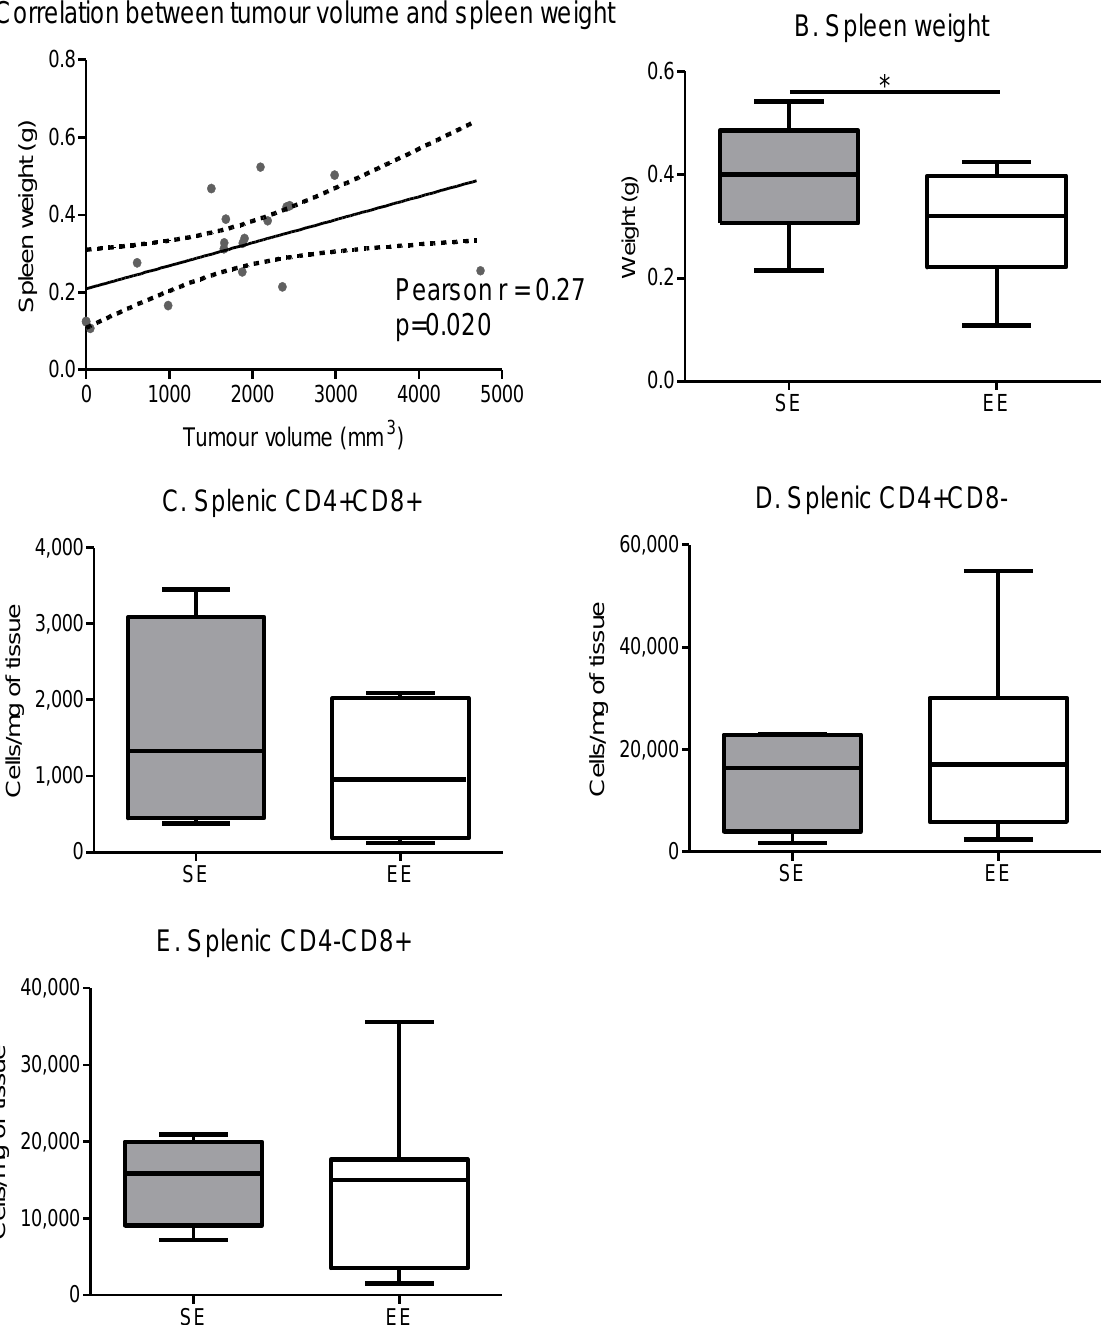
Figure 8. Spontaneous physical activity decreases spleen weight in correlation with tumour volume. ( A ) Correlation between tumour volume and spleen weight independent of environment, data were analysed by Pearson’s correlation test ( n = 10 mice/group) ( B ) Spleen weight depending on the environment, results are grams ( n = 10 mice/group) ( C ) Spleen CD4+ CD8+ maturation, results are in cells per mg of tissue. ( D ) Spleen CD4+ CD8 − maturation, results are in cells per mg of tissue. ( E ) Spleen CD4 − CD8+ maturation, results are in cells per mg of tissue. Phenotyping is performed on 5 mice spleen/group. Data are mean ± SEM. Data were analysed by Mann–Whitney t -test. Representative data are shown: * p < 0.05, SE vs. EE.